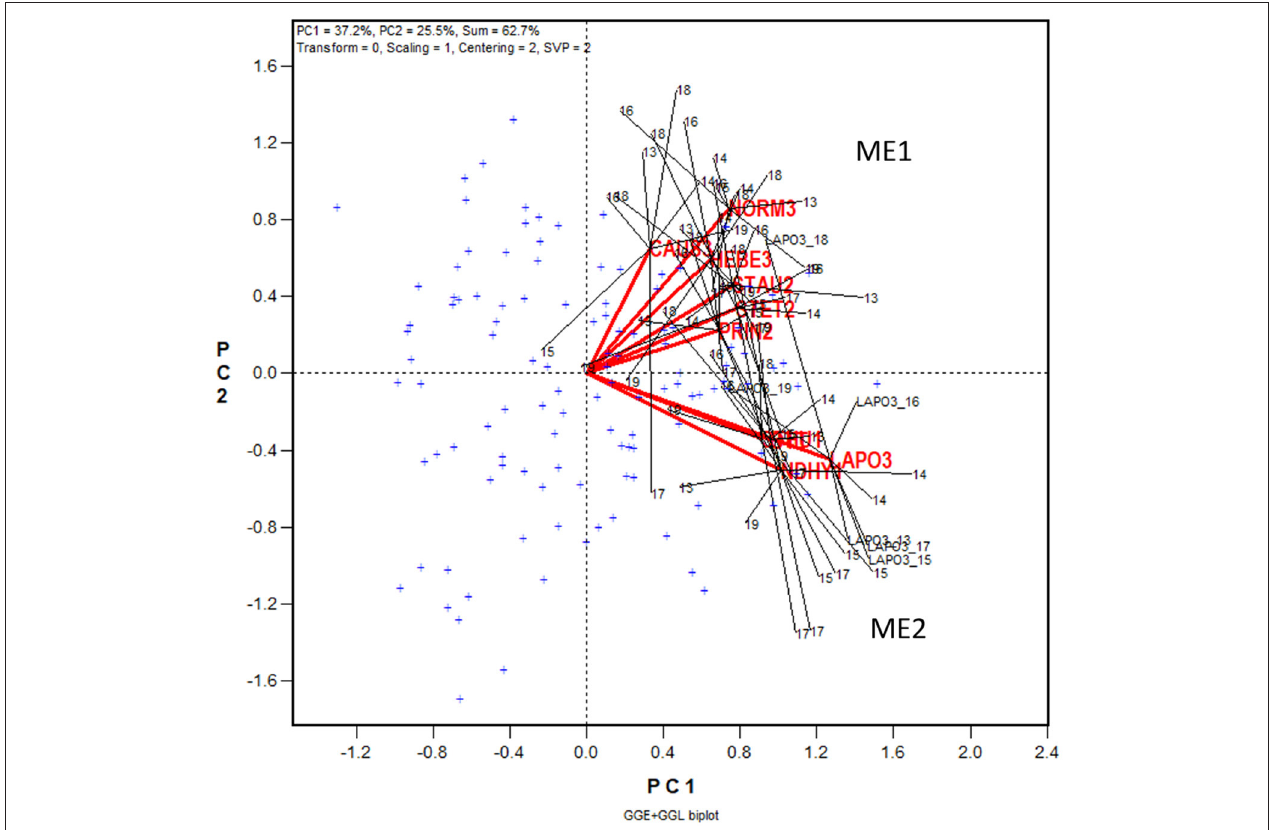
FIGURE 4 | GGE GGL biplot modified from Figure 3 to show two groups of locations or oat mega-environments (ME) in Quebec. Mega-environment 1 (ME1) + consists of Zone 2 and Zone 3 locations PINT2, PRIN2, STAU2, STET2, CAUS3, HEBE3, and NORM3, and mega-environment 2 (ME2) includes locations NDHY1, STHU1, LAPO3, and OTT. The trials conducted at each location are presented as a cluster of trials, with the location name placed at the center and the individual trials, indicated by the last two digits of the year, placed around it, and the trials are connected to the center with straight lines. Two locations are regarded as belonging to the same mega-environment if their clusters overlap; they are regarded as belonging to different mega-environments otherwise. The variation in the placement of the locations between mega-environments represents repeatable GE and the variation in the placement of the trials within mega-environments represents unrepeatable GE. The genotypes are displayed as “ ” in blue for clarity. +